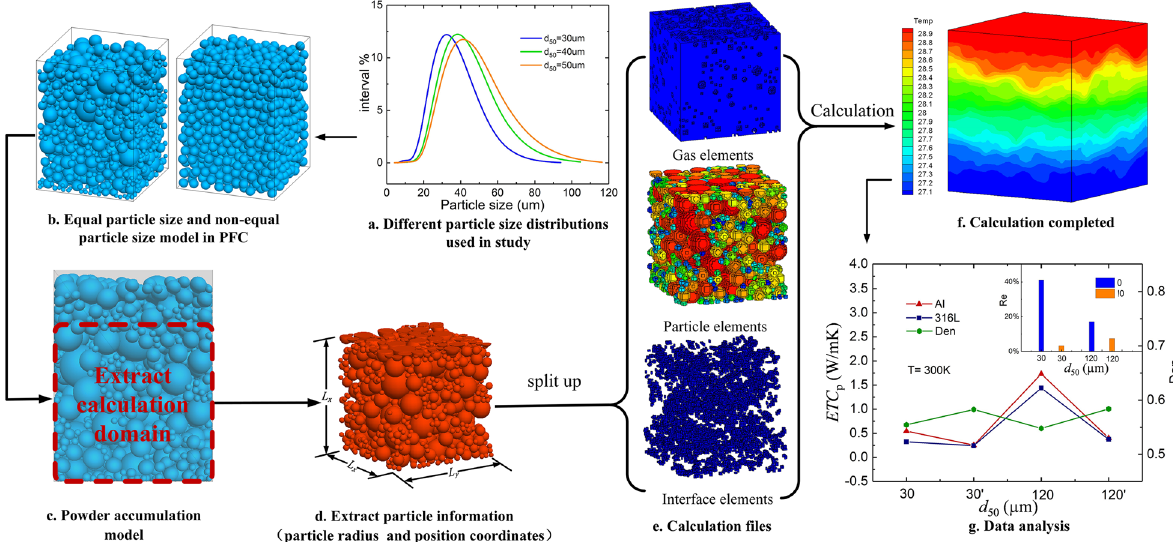
Figure 1 The whole analysis processes of ETC